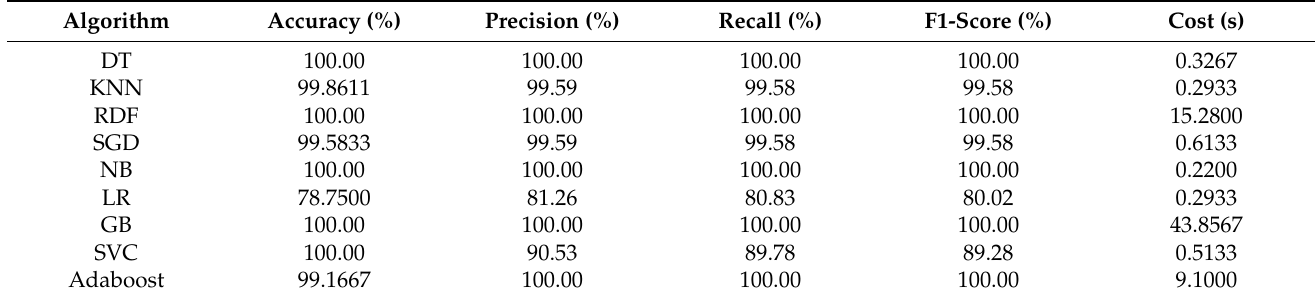
Table 6. Global performance comparison of ML models using capacitance (Cs)